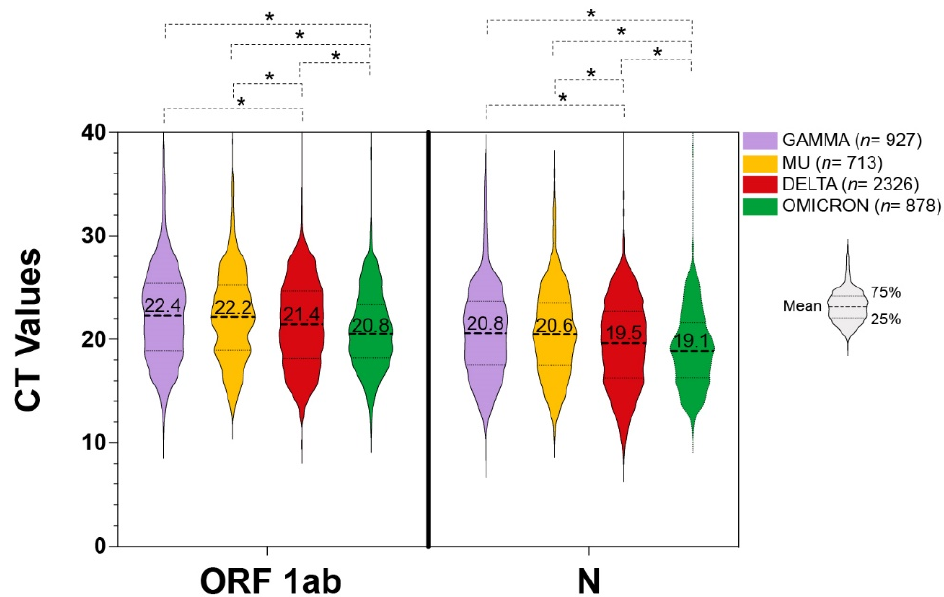
Figure 3. Distribution of the Cycle threshold (Cts) of VOIs and VOCs. The line indicates the average Ct for each variant. VOCs: Gamma ( n = 928), Delta ( n = 2322), Omicron ( n = 878) and VOI Mu ( n = 714). * Significant differences ( p < 0.05).